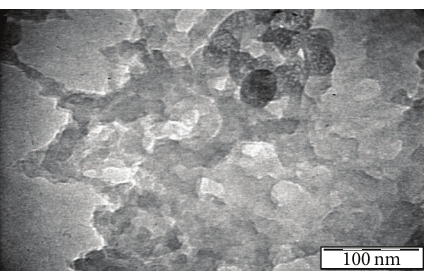
Figure 7: TEM analysis of FeNPs synthesized using Henna leaves extract.